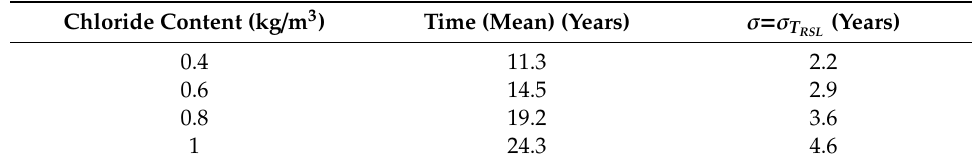
Table 5. Mean and Standard Deviations of predicted time to reach specified chloride concentrations at the rebar level used to establish the Standard deviation of RSL ( σ T t insp = 8 years ).